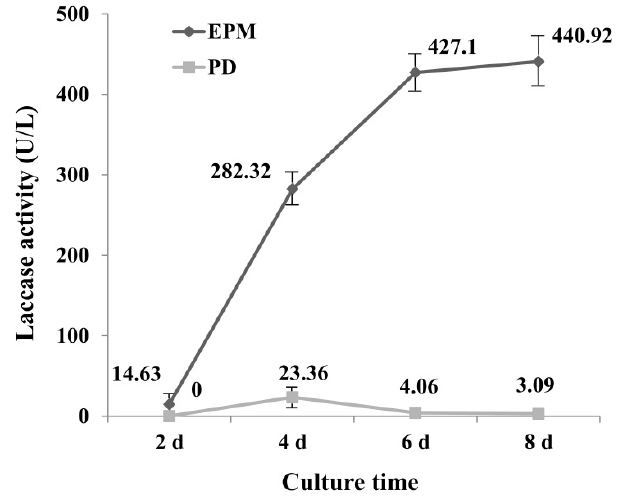
Figure 1. Activity of laccase under EPM and PD medium (U L − 1 ). EPM = Enzyme-producing medium; PD = Potato Dextrose medium. Crude laccase was obtained from the supernatant of G. lucidum mycelium culture. The error bars represent the standard deviation of triplicate samples.